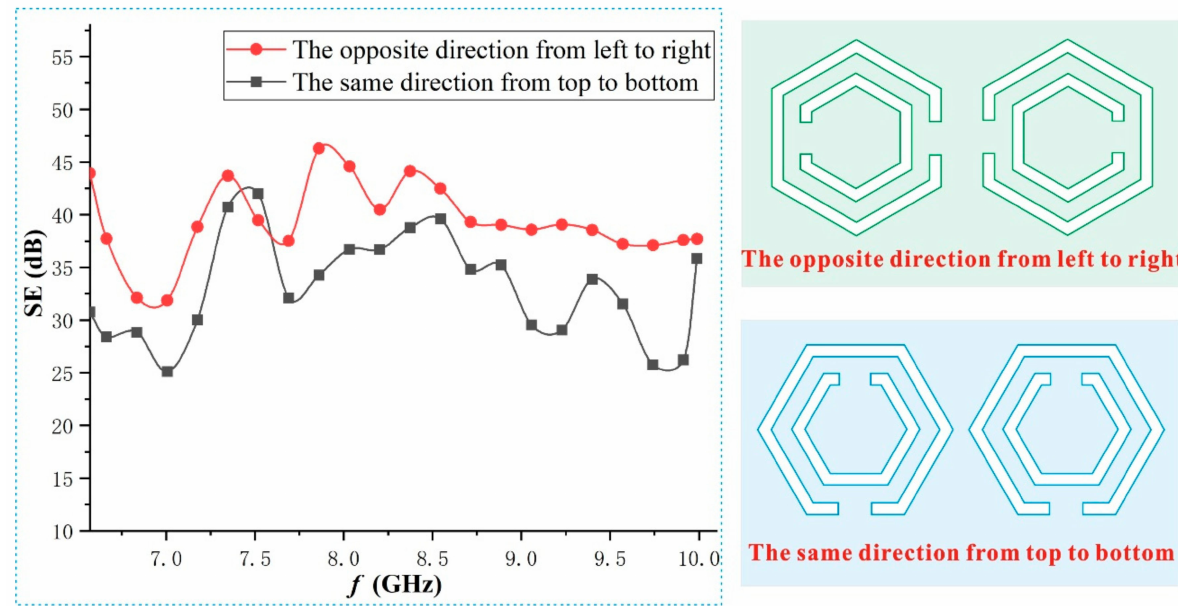
Figure 8. Influence of the SRR arrangement on the SE of the